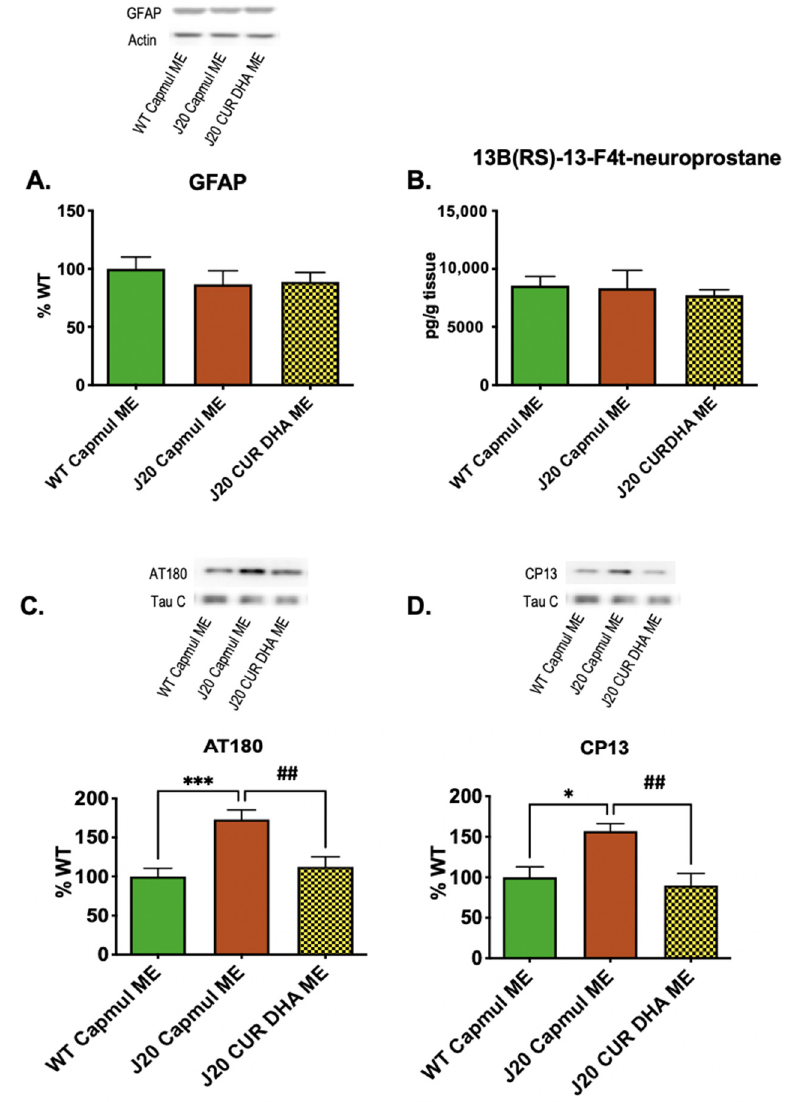
Figure 5. Effect of intranasal administration of CURDHA-ME on GFAP, neuroprostanes and Tau phosphorylation levels in transgenic J20 mice. ( A ) Effect of intranasal administration of CURDHA-ME on inflammation by immunoblot analysis of GFAP of hippocampal lysates from J20 mice. Results are normalized to β -tubulin levels. Results are represented as percentage of the control (WT Capmul ME). ( B ) Effect of intranasal administration of CURDHA-ME on neuroprostane levels (13B(RS)-13-F4t- NeuroP by LC-MS/MS) in prefrontal cortices lysates from J20 mice. WT and J20 mice received a ME containing Capmul oil as vehicle. Results are represented as mean ± SEM. ( C , D ) Effect of intranasal administration of CURDHA-ME on Tau phospho-epitopes AT180 (Thr231) ( C ) and CP13 (Ser202) ( D ) by immunoblot analysis of hippocampal lysates from J20 mice. (One-Way ANOVA followed by a Tukey post-hoc test, *** p < 0.0001, * p < 0.05 vs. WT mice, ## p < 0.01 vs. J20 Capmul ME mice). WT and J20 mice received a ME containing Capmul oil as vehicle. All the results are normalized to total Tau level (Tau-C) and represent the percentage of the control (WT Capmul